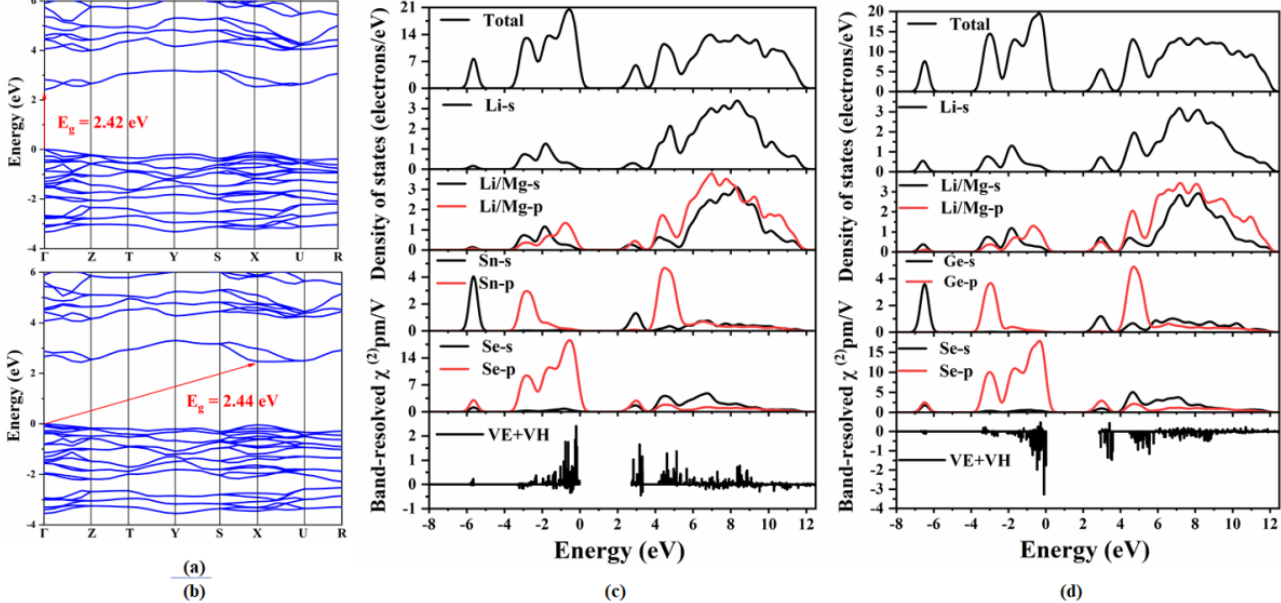
Figure 3. Calculated band structures of ( a ) Li 2 MgSnSe 4 and ( b ) Li 2 MgGeSe 4 ; total and partial density of states and the band-resolved NLO susceptibility χ (2) of ( c ) Li 2 MgSnSe 4 and ( d ) Li 2 MgGeSe 4 .